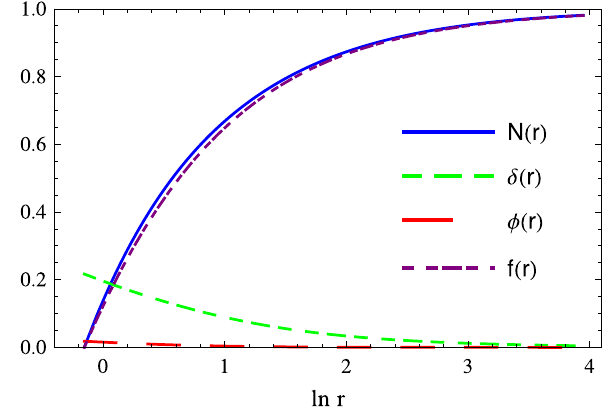
Fig. 2 A scalarized charged black hole solution with α = 8 . 083 located in the n = 0 (α ≥ 8 . 019 ) fundamental branch in the EMS theory. This is plotted as a function of ln r on and outside the horizon at ln r = ln r + = − 0 . 154